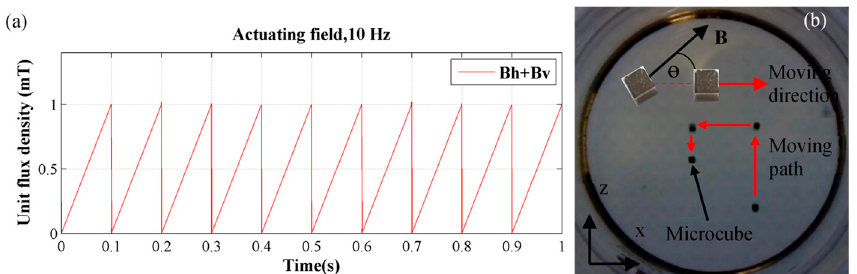
Figure 11. Rocking-slip locomotion by gradient based field. ( a ) a sample of 10Hz frequency produces the superposition of the horizontal and vertical field, B h and B v . ( b ) the motion path of the microcube which is wrenched by the actuating force to rock up and down to slip forward.